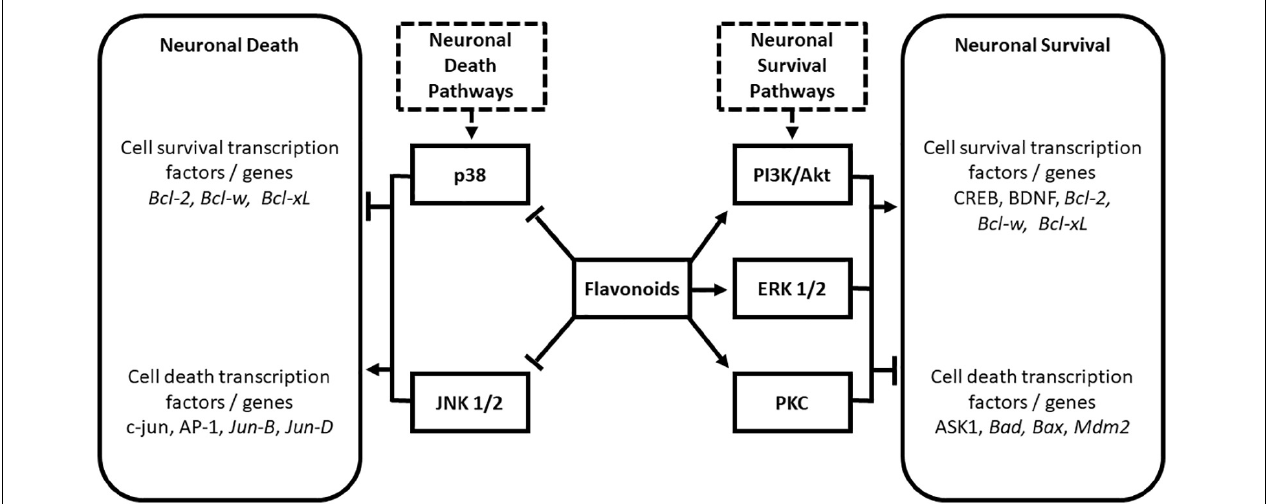
FIGURE 1 | Modulation of neuronal death and survival pathways by the flavonoid subclasses of anthocyanins, flavanols, and flavanones. Modified from Solanki et al. (2015). AP-1, activated protein 1; ASK1, apoptosis signal-regulating kinase 1; Bad, BclxL/Bcl-2-associated death promoter; Bax, Bcl-2-associated X protein; Bcl-2, B-cell CLL/lymphoma 2; Bcl-w, BCL2-like 1; BDNF, Brain-derived Neurotropic Factor; CREB, cAMP response element-binding protein; ERK, extracellular signal-regulated protein kinase; JNK, c-Jun N-terminal kinase; Mdm2, murine double minute 2; PI3K/Akt, phosphatidylinositol-3 kinase/Protein kinase B; PKC, protein kinase